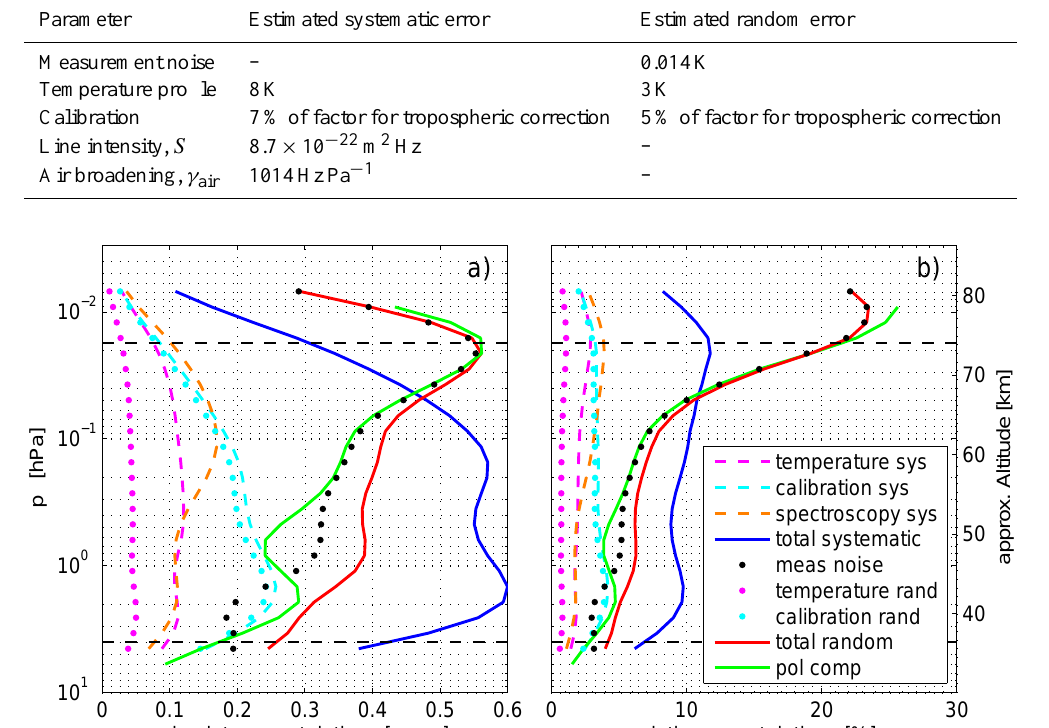
Fig. 5. Estimated uncertainties for MIAWARA-C in VMR ( a ) and relative to the a priori profile ( b ) for 21 March 2010. The 1- σ random error (solid red) is equal to the sum of uncertainties caused by the measurement noise (dotted black), by random temperature (dotted magenta) and calibration uncertainties (dotted cyan). The systematic 2- σ error (solid blue) is the sum of the errors caused by the uncertainties in the temperature profile (dashed magenta), in the calibration (dashed cyan) and in the spectroscopic parameters (dashed red) multiplied by 2. The measurement noise error estimated by comparing the two polarisations is shown in solid green. All plots use MIAWARA-C data with AoA > 0.5. The dashed horizontal lines indicate the reliable altitude range (AoA >